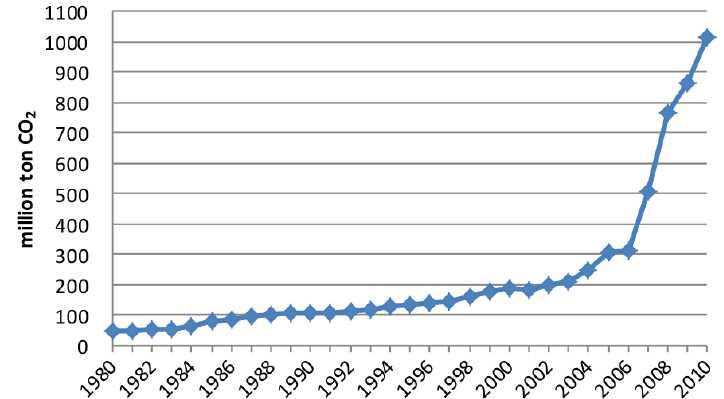
Figure 2. Total CO 2 emission in Chinese logistics